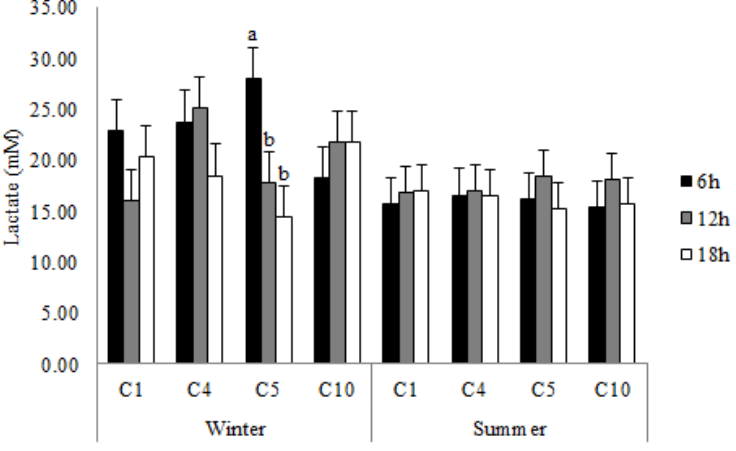
Figure 2. Blood lactate concentrations (LSM ± SEM) in pigs transported for 6, 12 and 18 h in the compartments C1, C4, C5 and C10 during winter and summer. a,b Least squares means without a common superscript differ ( p < 0.05).